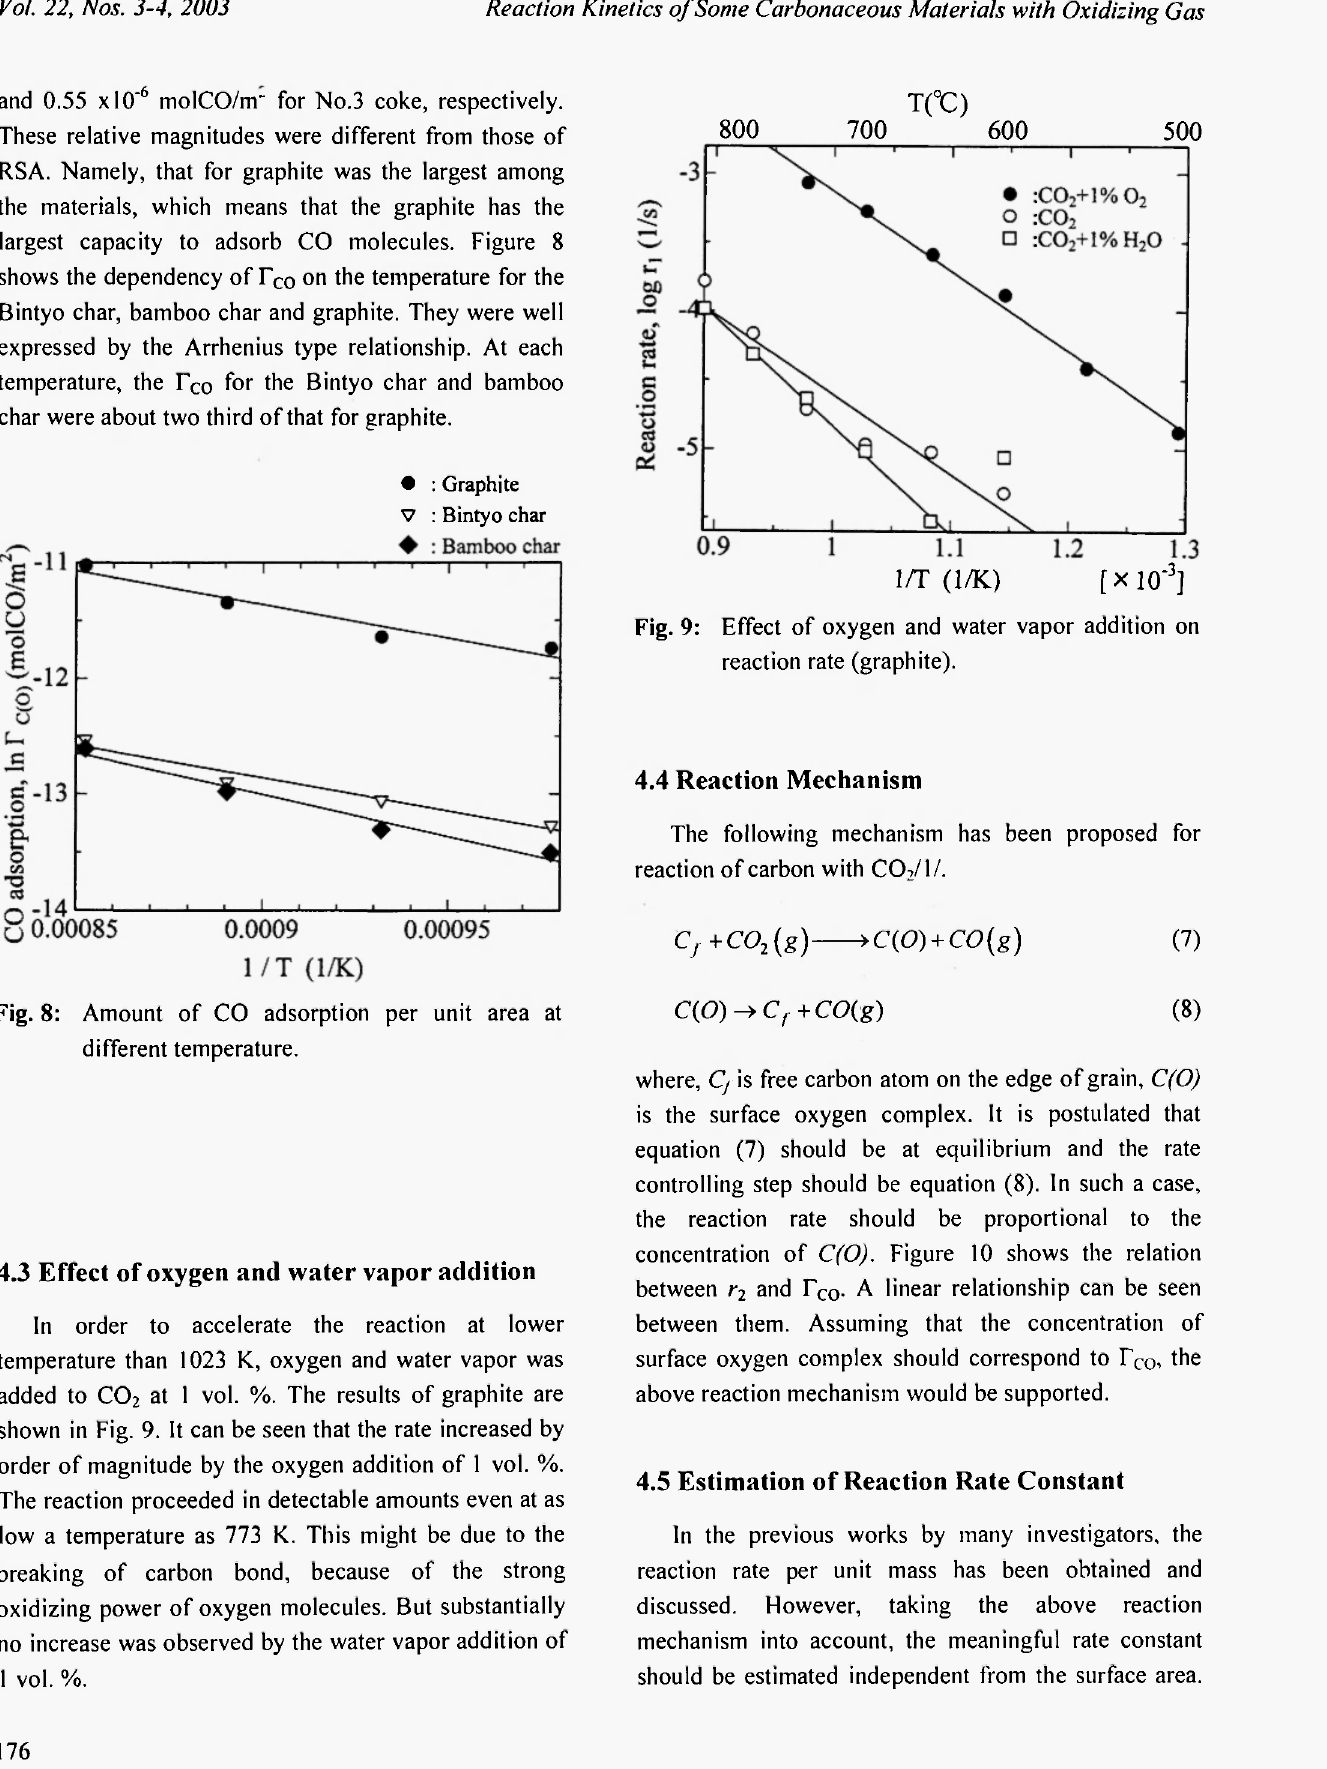
Fig. 8: Amount of CO adsorption per unit area at different temperature.